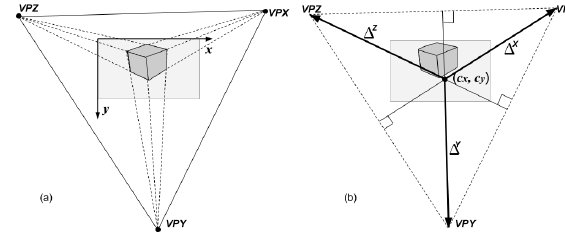
Figure 2. (a) Parallel line segments extend to vanishing lines which intersect at vanishing points. (b) The principal point is located at the center of the vanishing point triangle, and vectors ∆ X , ∆ Y , ∆ Z toward the vanishing points partially determine the rotation matrix. Figure 3. The ‘Perspective Pyramid’ is formed with the vanishing point triangle as the base, and the apex ‘behind’ or ‘above’ the principal point. The apex is at a height such that all three sides are right triangles, and that height is the focal length f . 3D image space vectors R x , R y , R z from CS to the vanishing points form the rotation